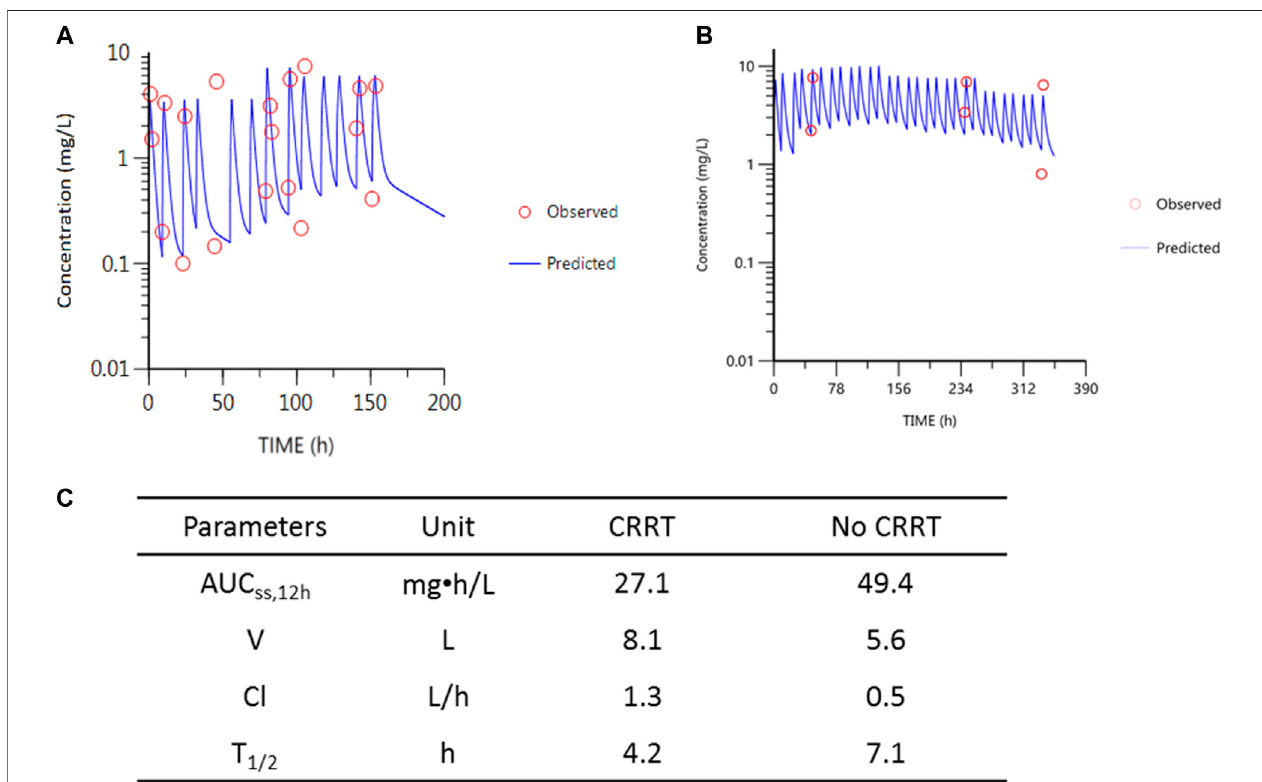
FIGURE3| PKparametersofpolymyxinBandthesimulationsforpatient1. (A) Observedconcentrationsvs.predictedconcentrationsduringCRRT. (B) Observed concentrations vs. predicted concentrations after recess of CRRT. The last two samples in (B) were deviated from the blue line due to the dose adjustments from 1.5 mg/kg(with0.5 mg/kginhalation)to1.0 mg/kginfusion.Redcirclesrepresentobservedconcentrations;bluelinerepresentsthepredictedconcentrationsaccording to the two-compartmental PK model. (C) Table for the PK parameters during CRRT and without